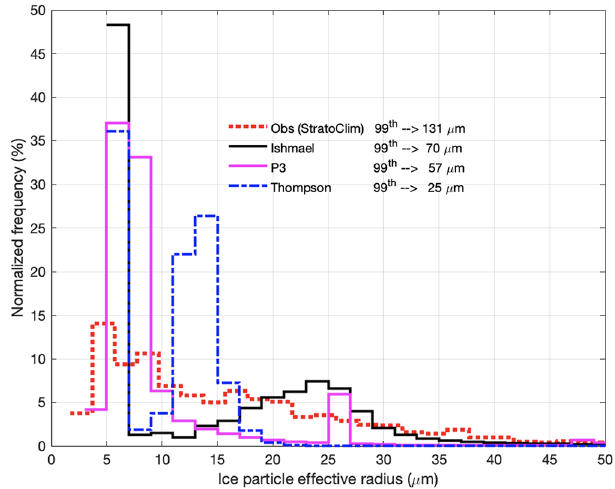
Figure 13. Effective radius distribution at 17km from observations (red) and simulations using the ISHMAEL (black), P3 (purple), and Thompson (blue)